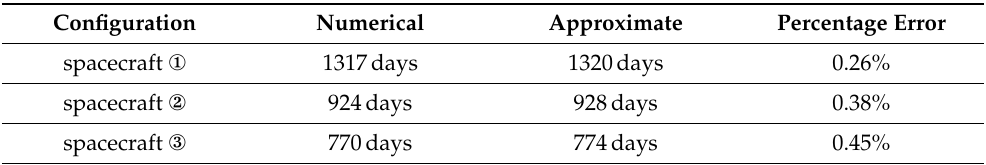
Table 2. Decay time from 1000km to 300km estimated with an orbital propagator and the approxi- mate method. A mean solar activity is